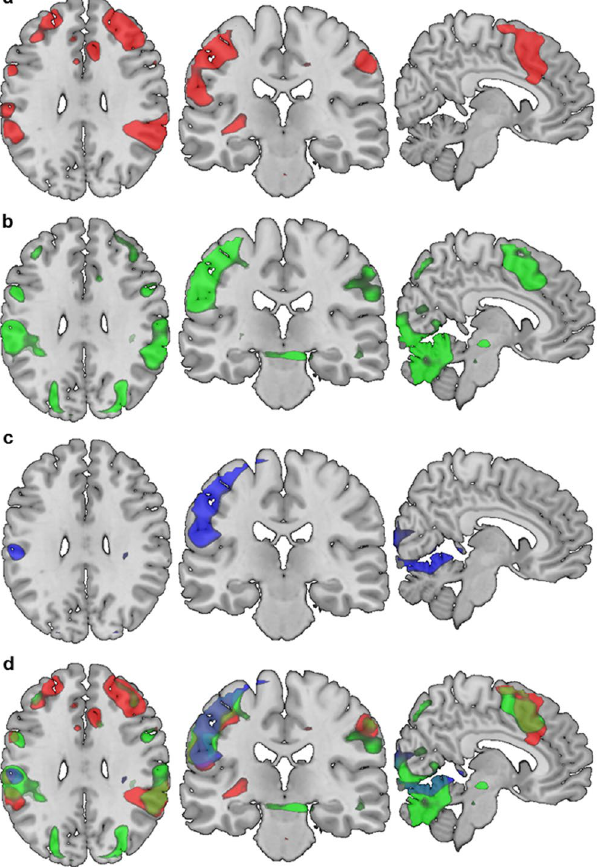
Figure 2. Whole-brain task activation of all participants (N = 39) during the ( a ) free condition (red), ( b ) timed choice condition (green), ( c ) no choice condition (blue), and ( d ) free, timed choice, and no choice conditions, all significant p < 0.05 FWE cluster-corrected (initial threshold p < 0.001, uncorrected). Coordinates (MNI): x = 6, y = − 22.5, z =